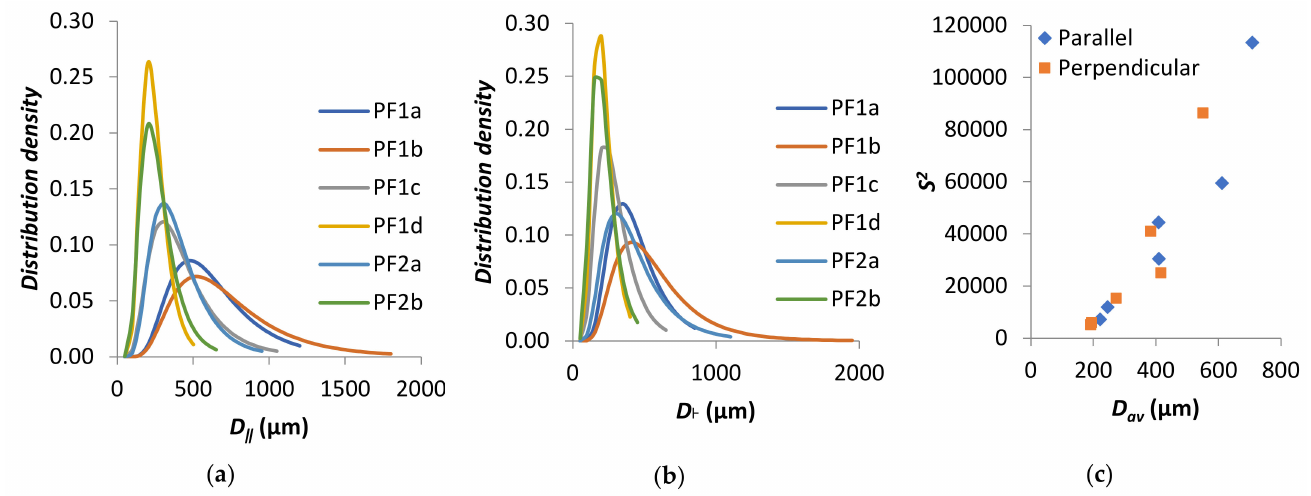
Figure 5. Log-normal density distribution for PF1 and PF2 samples in ( a ) parallel direction and ( b ) perpendicular direction. ( c ) S 2 as a function of D av